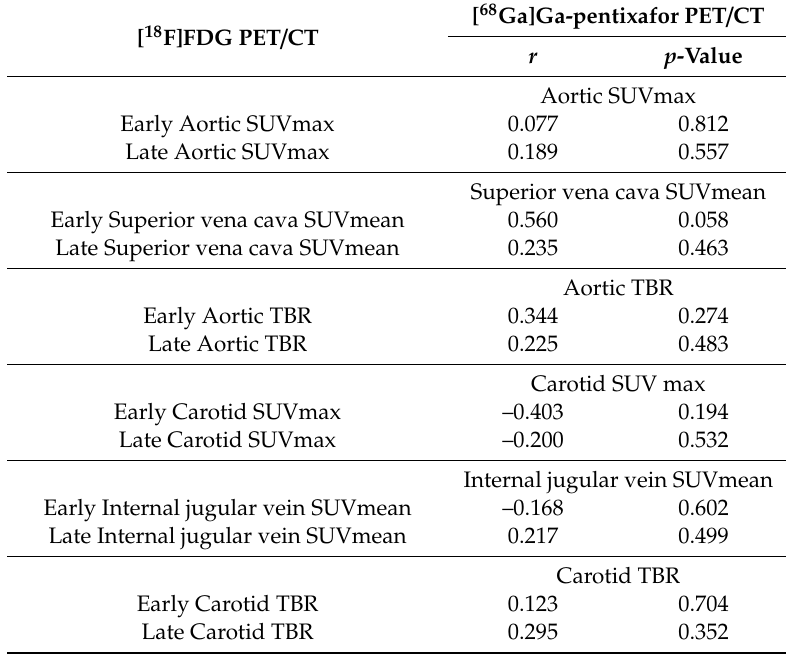
Table 3. Correlation between [ 18 F]FDG PET and [ 68 Ga]Ga-pentixafor PET-derived